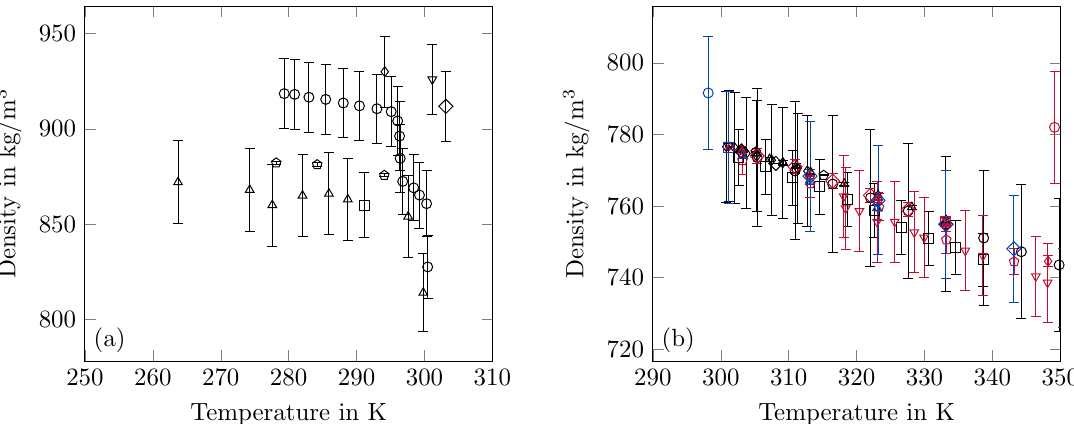
Figure 2. Summary of density data from the literature in the solid ( a ) and liquid ( b ) state. The error bars are the specified uncertainty of the data. The values named OR are results from our own